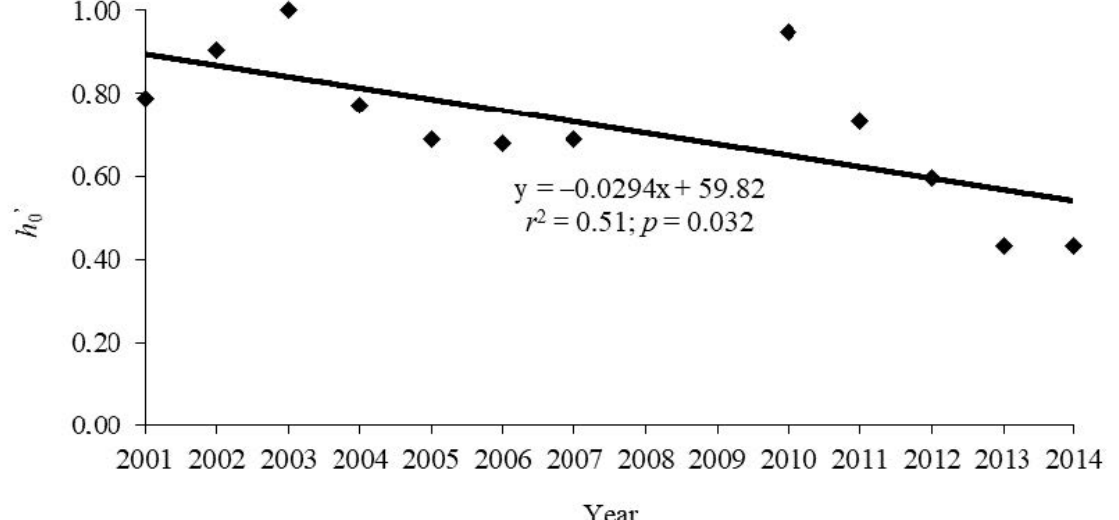
Figure 4. Correlation of racial diversity (normalized Shannon diversity index, h 0’ ) of isolates of P. infestans with year of study in potato breeding fields in Estonia for 2001 to 2014. The data were fitted by a linear regression.